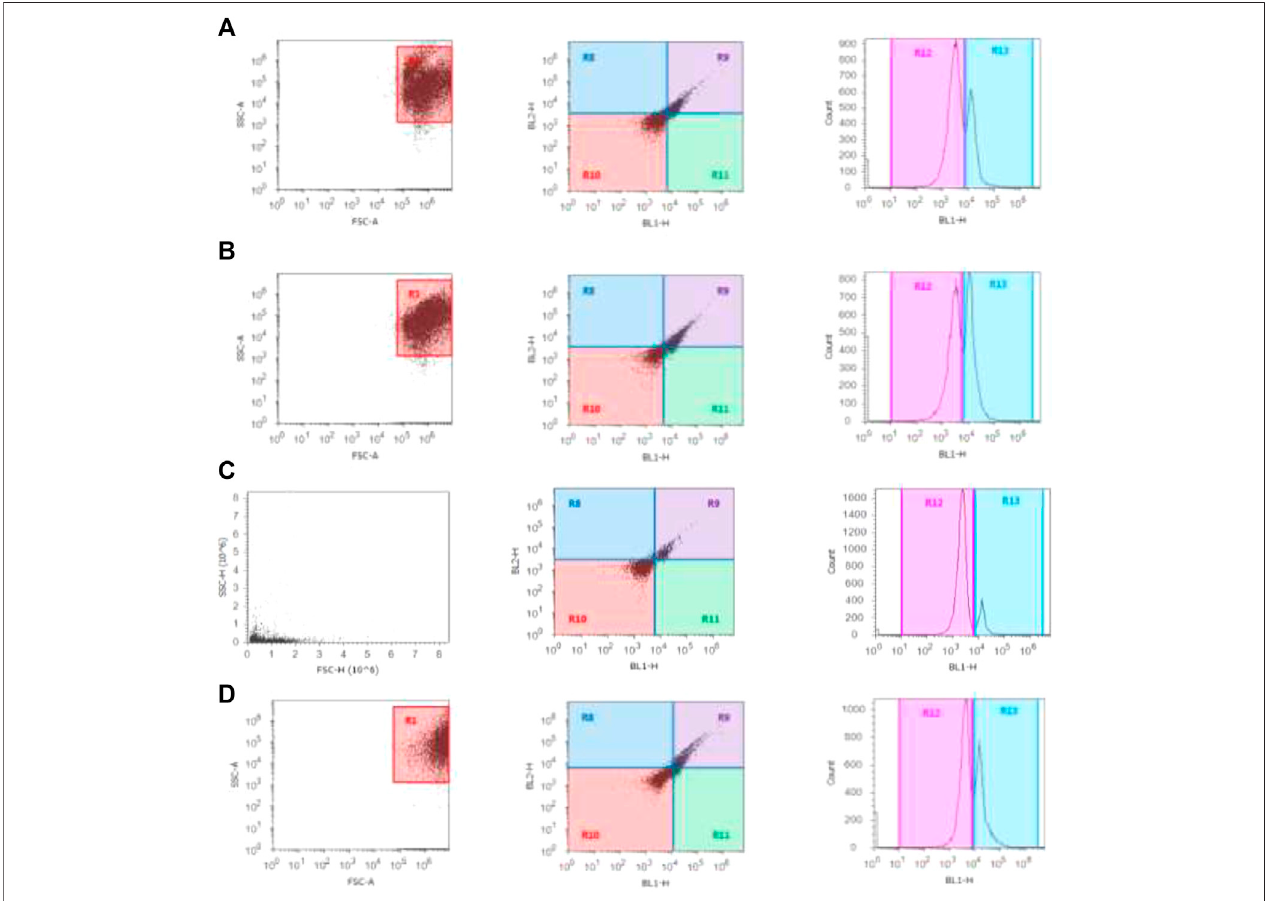
FIGURE 6 | Cell cycle scatter and histograms for different groups (A – D) . The forward scatter (FS) and side scatter (SS) were measured to identify single cells. The X -axis in the histogram depicts propidium iodide fl uorescence as a function of DNA content, while Y -axis re fl ects cells count in the 3 cell cycle phases (G0/G1, S, and